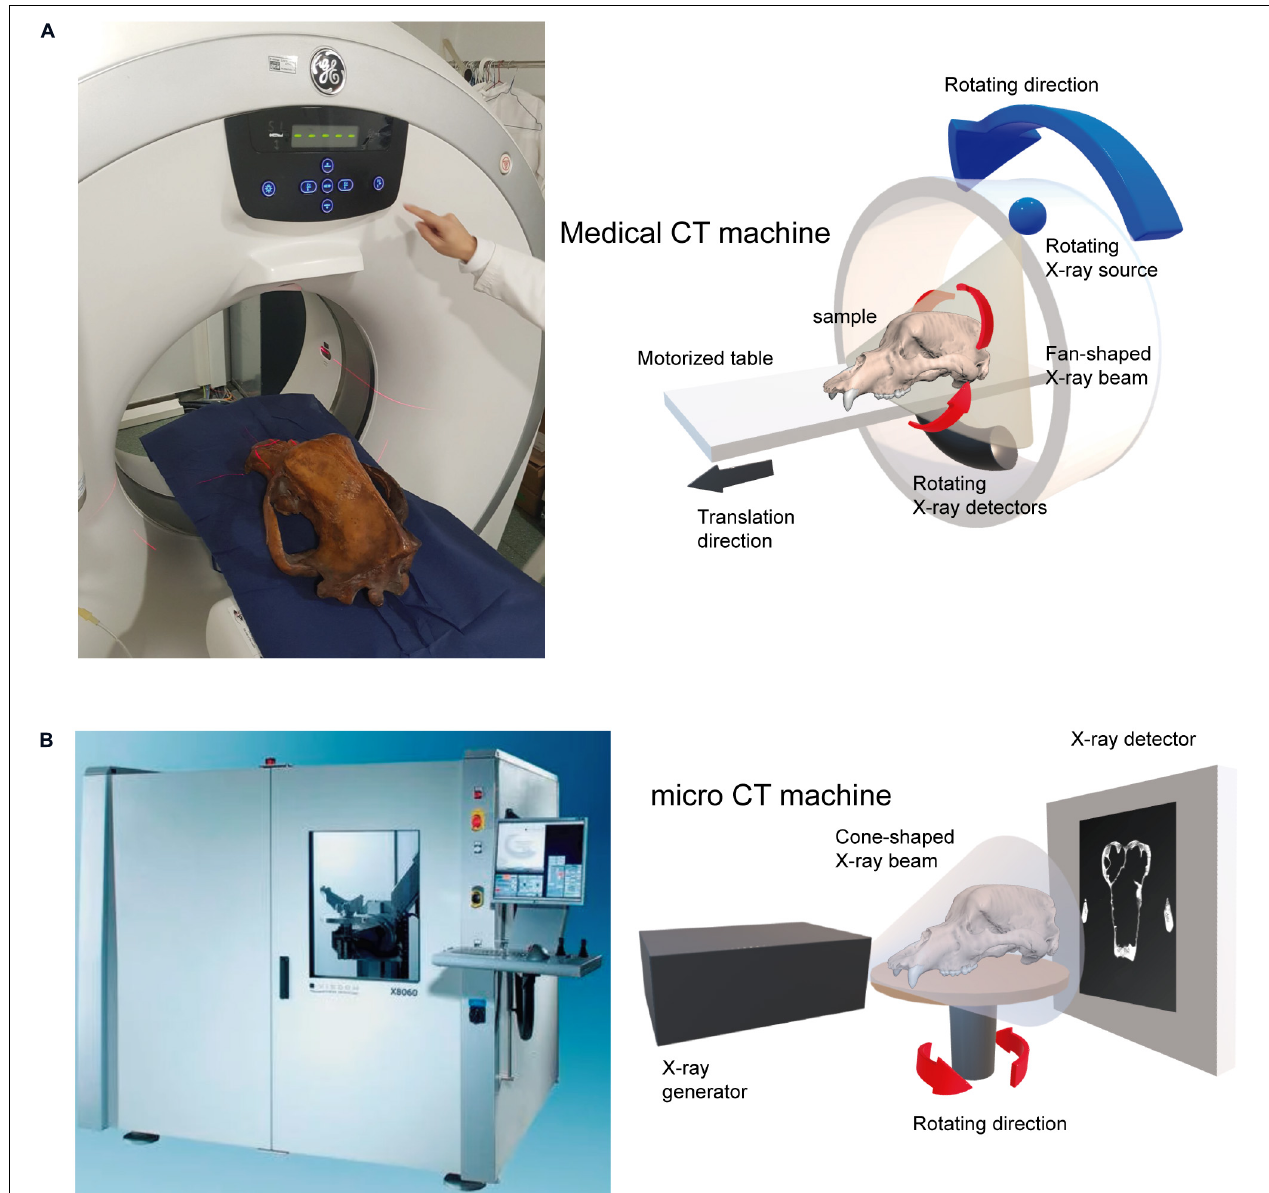
FIGURE 1 | Examples of acquisition machines used to scan our sample of cave bear skulls. (A) XCT machine, GE Medical Systems (Brivo CT385 Series) of the Clínicas Rincón, Málaga. (B) High - resolution µ CT X8060 of the Vienna Micro-CT Lab (https://www.micro-ct.at/en/) at the Department of Evolutionary Anthropology (see Supplementary Data